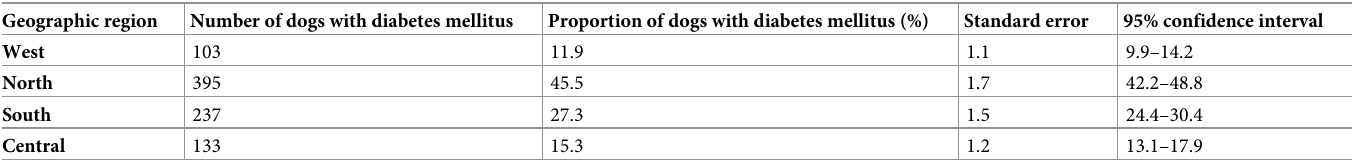
Table 5. Geographic region of 868 dogs with diabetes mellitus. Geographic region Number of dogs with diabetes